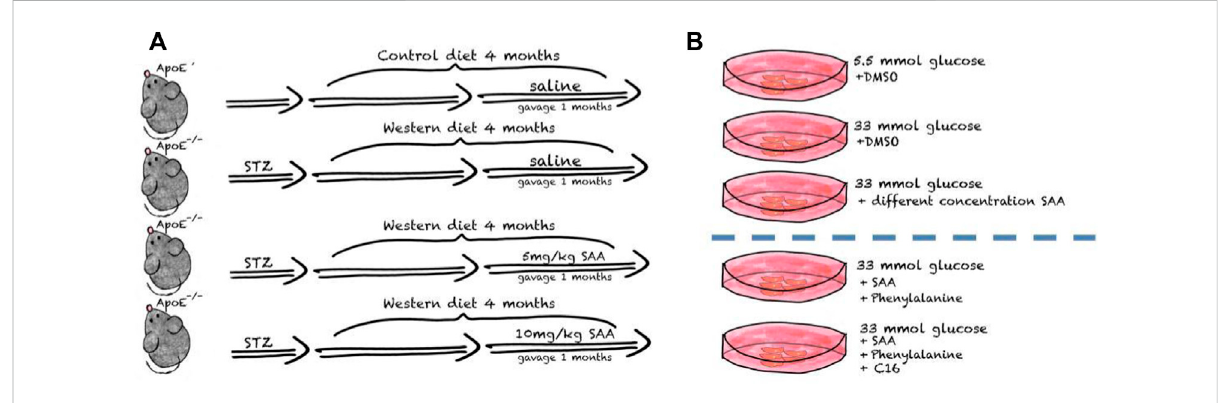
Schematic diagram of SAA treatments in diabetic AS mouse model.